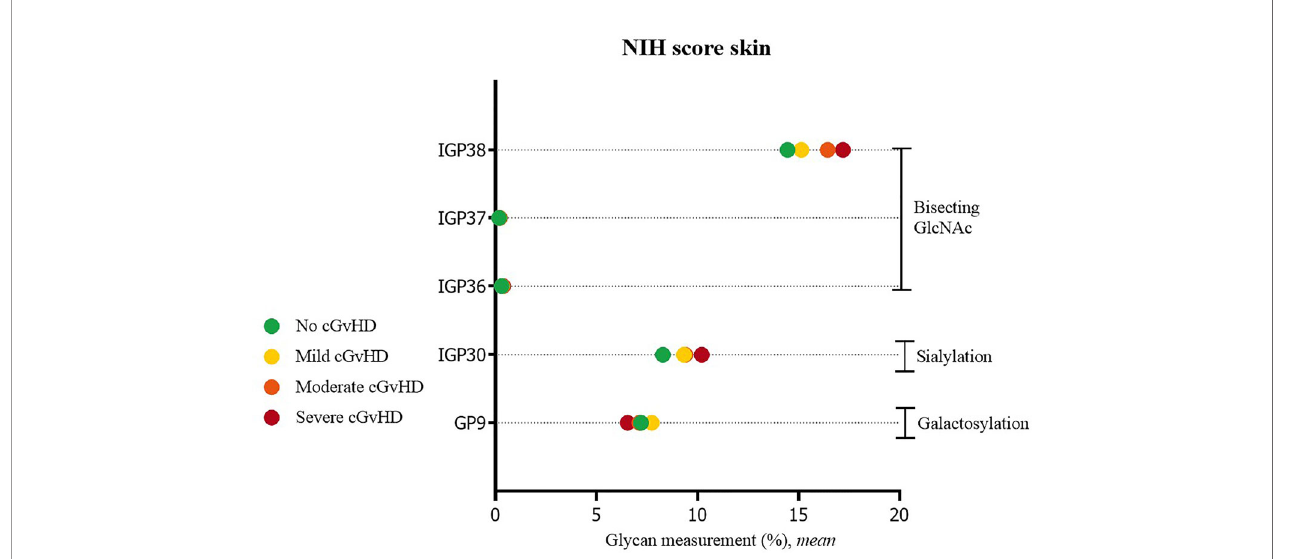
FIGURE 2 | Signi fi cant differences in glycan measurements in patients with no skin cGvHD and among various degrees of skin NIH cGvHD